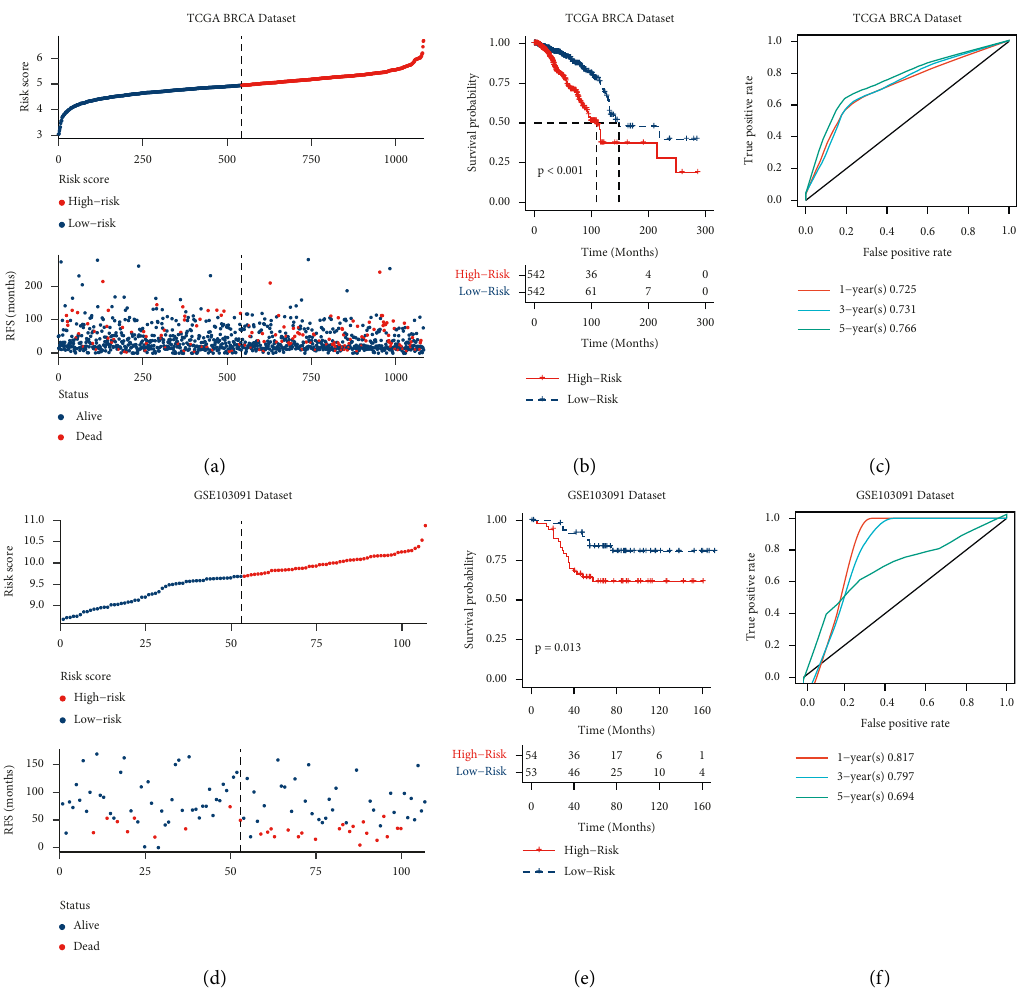
Figure 2: Establishment and verification of the risk score model. (a, d) Distribution of risk score and survival status in the corresponding datasets. (b, e) Survival analysis between high- and low-risk score groups in the different datasets. (c, f) 1-, 3-, and 5-year ROC curves for the different datasets. (a–c) The results from the analysis of the TCGA BRCA dataset (TCGA dataset); (d–f) results from the analysis of the GSE103091 dataset. RFS: relapse-free